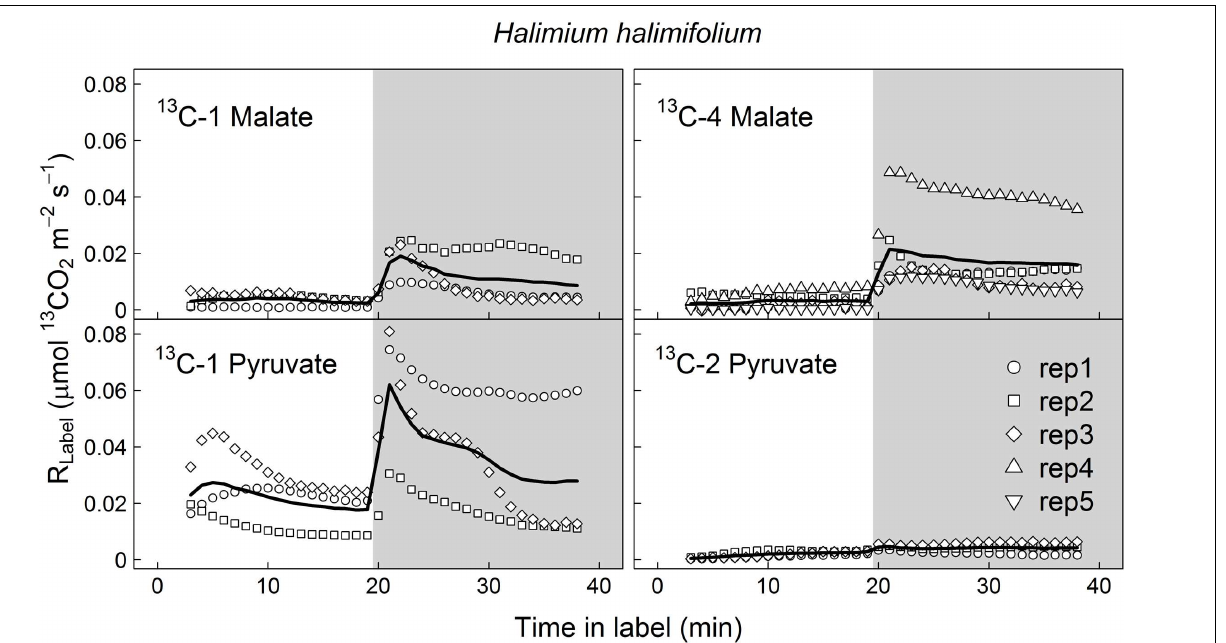
Frontiers in Plant Science |